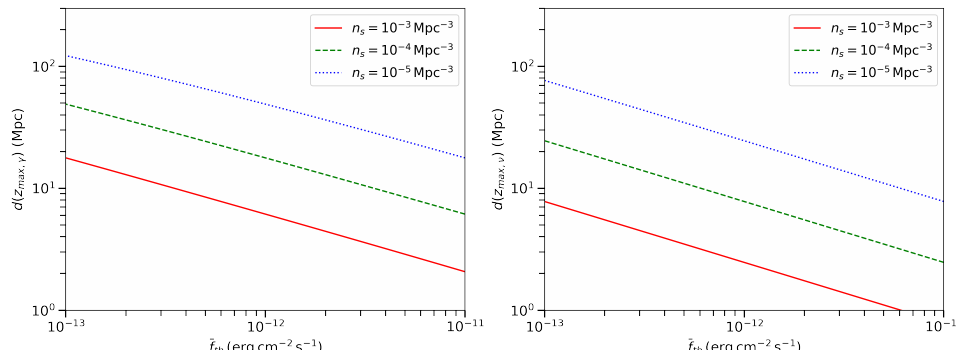
Figure 1. The horizon distance as a function of telescope sensitivities. Left panel: observation of >2 TeV gamma-rays. Right panel: observation of >100 TeV neutrinos. The three lines from top to bottom correspond to three source number densities, 10 − 3 , 10 − 4 , and 10 − 5 Mpc − 3 .